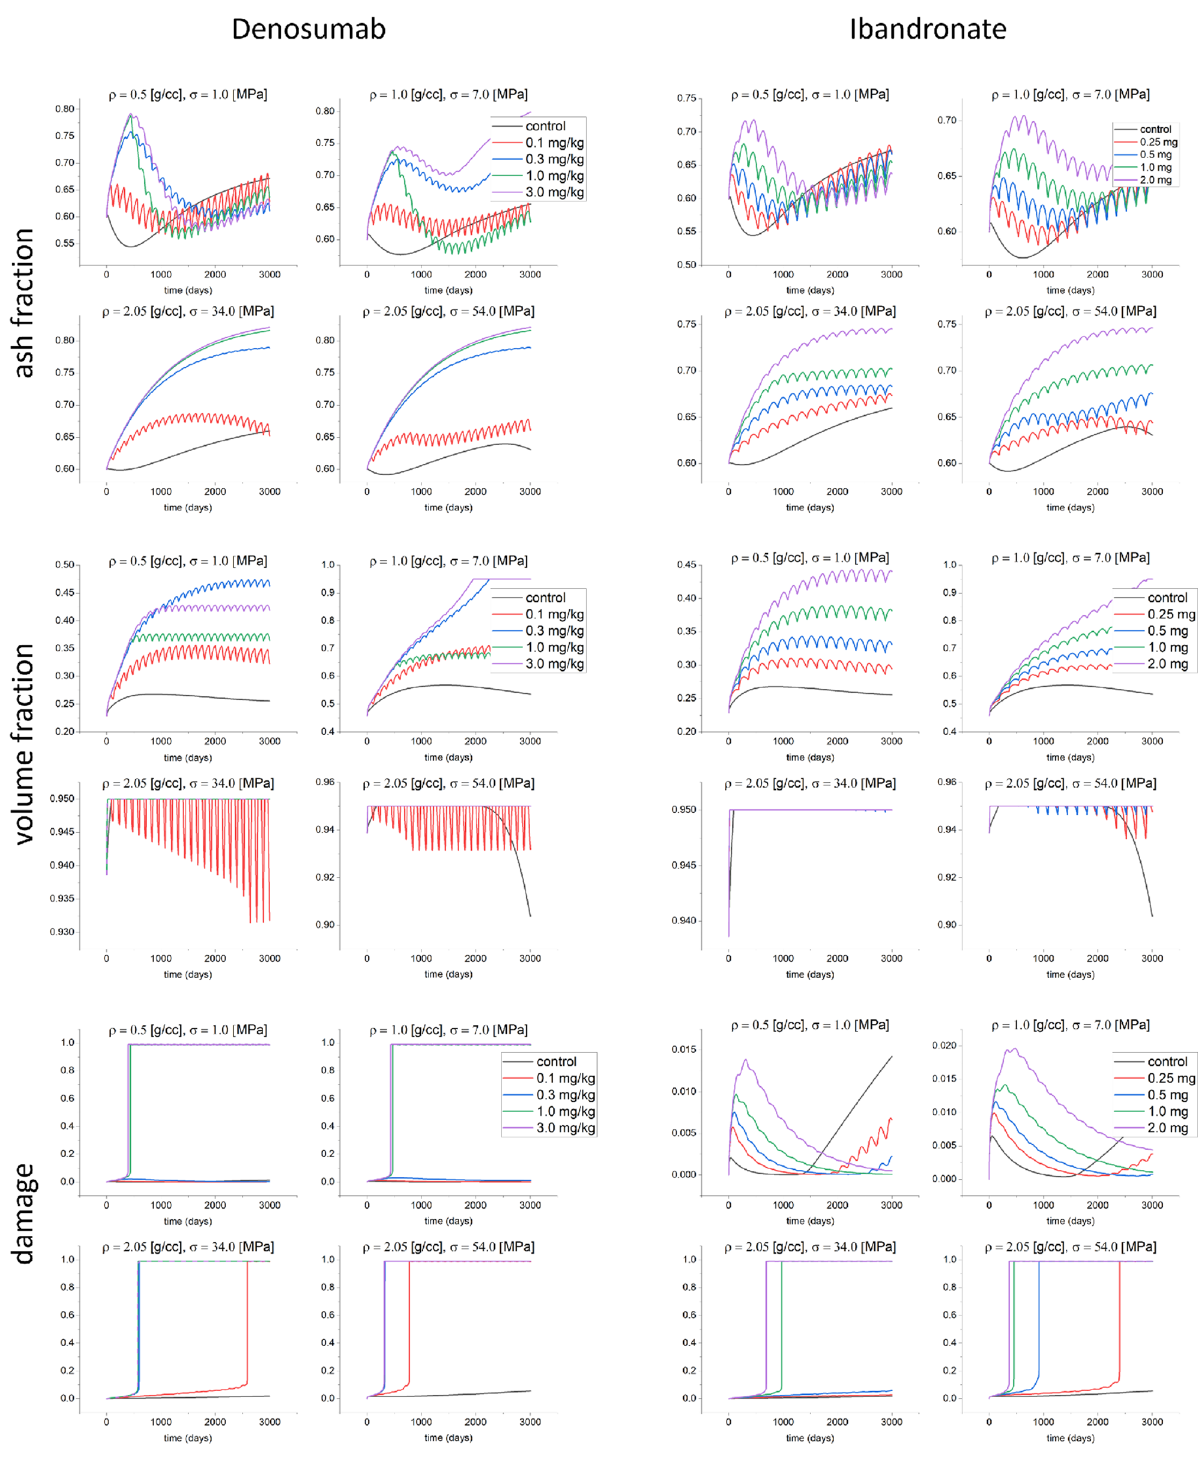
Figure 3. Evolution of the ash fraction, volume fraction and damage for the control case, and different doses of denosumab (0.1, 0.3, 3.0 mg/kg) and Ibandronate (0.25, 0.5, 1.0 and 2.0 mg) when applying constant stress of 1.0 0.5g / cm 3 , 7.0 MPa for an initial density of ρ MPa for an initial density of ρ = 2.05g / cm 3 for an initial density of ρ =